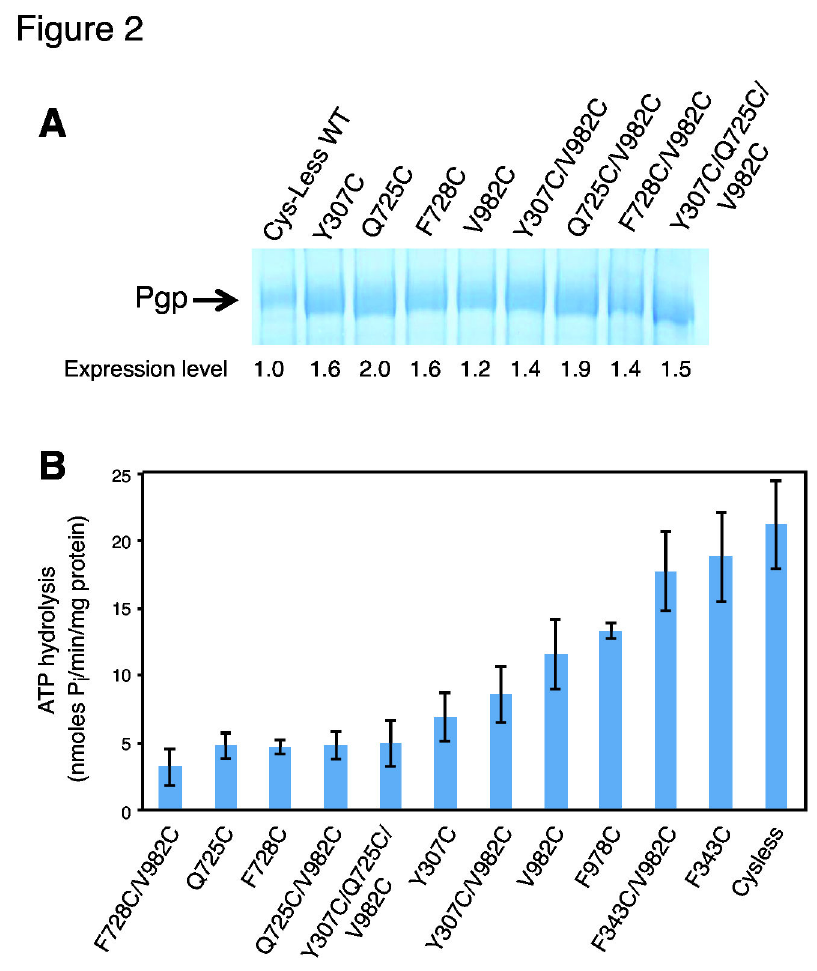
Figure 2. Some of the drug-binding pocket mutants exhibit very low basal ATPase activity. (A) The expression of mutant Pgps in High-Five insect cell membranes. Crude membranes of High-Five insect cells expressing indicated mutant Pgps were analyzed by standard SDS-PAGE method and proteins were stained with Colloidal Blue staining. Each lane contains 20 µg total membrane protein. Only the portion of the 7% Tris-Acetate gel with the Pgp band is shown. Expression level of mutant Pgps was quantified and compared to cysless WT Pgp using ImageJ 1.46r. (B) Basal ATP hydrolysis (in the absence of any added compound) of cysless WT and mutant Pgps is shown in bar graph format. The mutants are ordered from the lowest to the highest basal activity. Vanadate-sensitive Pgp-mediated ATP hydrolysis was measured as described in Materials and Methods. In all experiments, mutant Pgps (10-25 µg protein/100 µL) were incubated at 37°C and the ATPase activity was measured after 20 min reaction, in the presence of 5 mM ATP. At least three experiments were carried out for each mutant and error bars represent SD. doi: